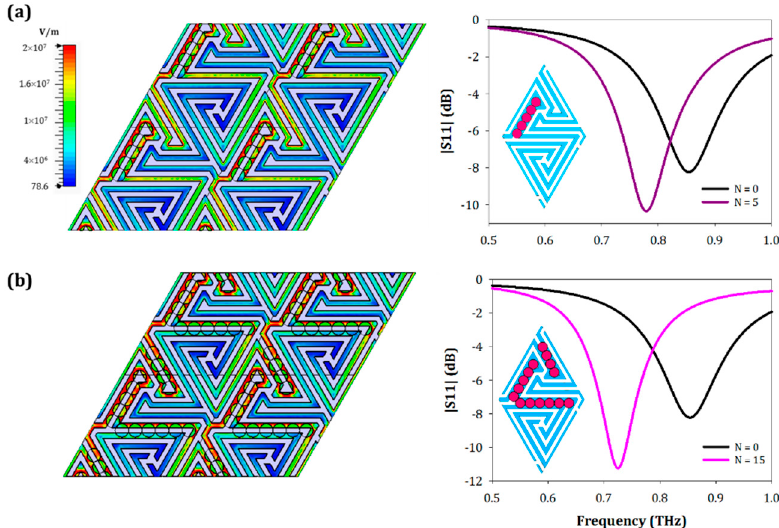
Figure 3. ( a ) Electric field distribution over the labyrinth surface for the designed structure with N = 5 ( A f = 5.48%) fungi placed at the regions of maximum electric field confinement (left) and reflection coefficient comparison with the bare structure (right). ( b ) Electric field distribution (left) and reflection coefficient (right) when placing N = 15 ( A f = 16.45%) fungi elements in the places where the electric field confinement is maximum (pink curve), and comparison with the bare structure (black curve).